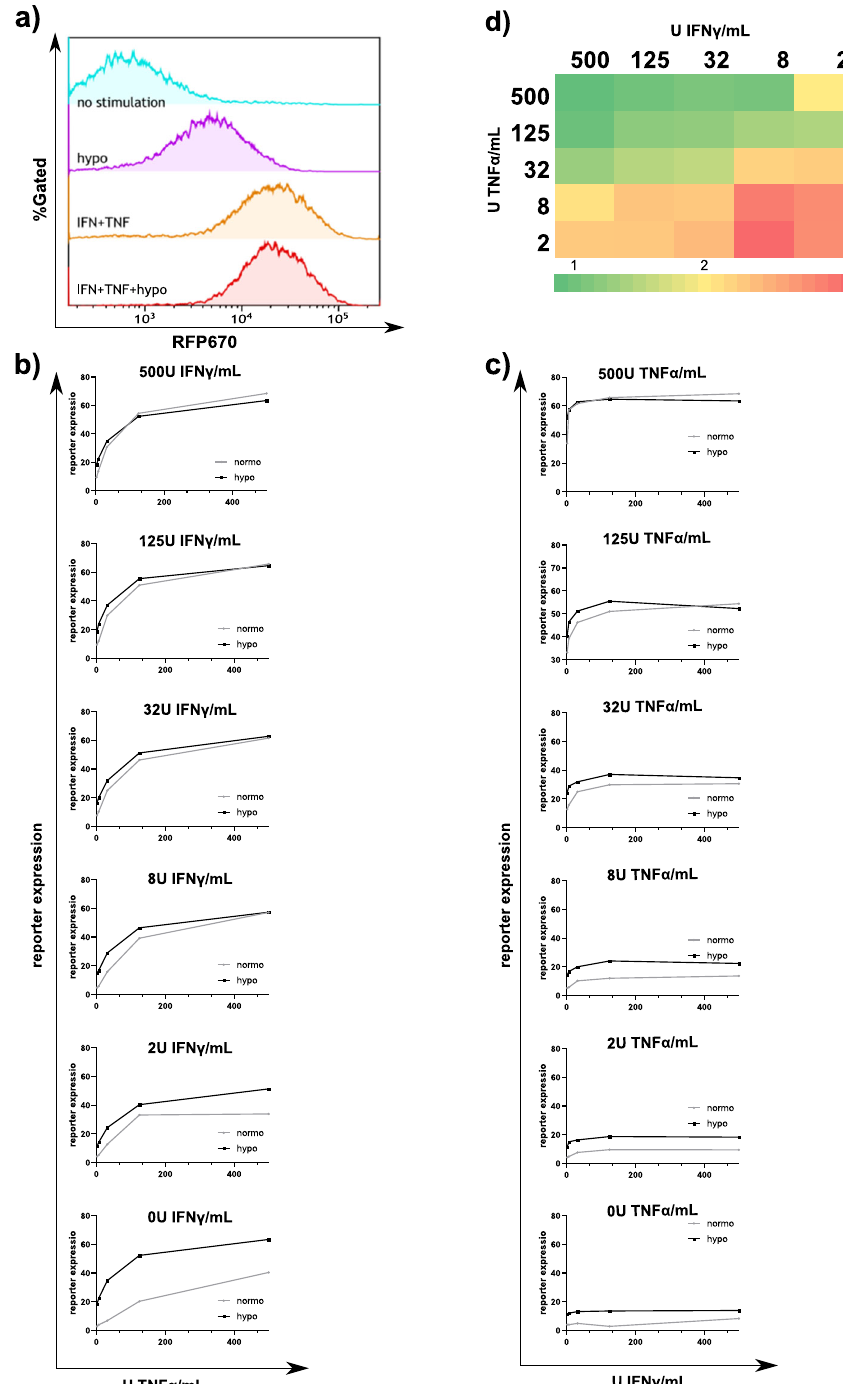
Fig. 4 The G1K06H1 promotor shows an additive response to hypoxia and cytokines with physiological cytokine concentrations. a Representative plots of HEK293T cells infected using lenti viral vectors with RFP670 under the control of the G1K06H1 promotor and ZsGreen controlled by the ef1 α core promotor. At 72 h following infection, the cells were treated for 48 h with 500 U/ml indicated cytokines and for 18 h under hypoxic or normoxic conditions, harvested and analyzed by fl ow cytometry. Data shown are ZsGreen-positive, single-discriminated and DAPI-negative results. b From the top panel to the bottom — cells were treated for 48 h with 500, 125, 32, 8, 2 or 0 U/mL of TNF respectively and veering IFN concentrations and placed under hypoxic or normoxic conditions for 18 h, cells were analyzed by fl ow cytometry as described above. Showing average of duplicates, error bars indicate standard deviation. c From the top panel to the bottom — cells were treated for 48 h with 500, 125, 32, 8, 2 or 0 U/mL of IFN respectively and veering TNF concentrations and placed under hypoxic or normoxic conditions for 18 h, cells were analyzed by fl ow cytometry as described above. Showing average of duplicates, error bars indicate standard deviation. d Ratios of reporter expression with different cytokine concentrations under hypoxic or normoxic conditions. Results are from one representative experiment of four